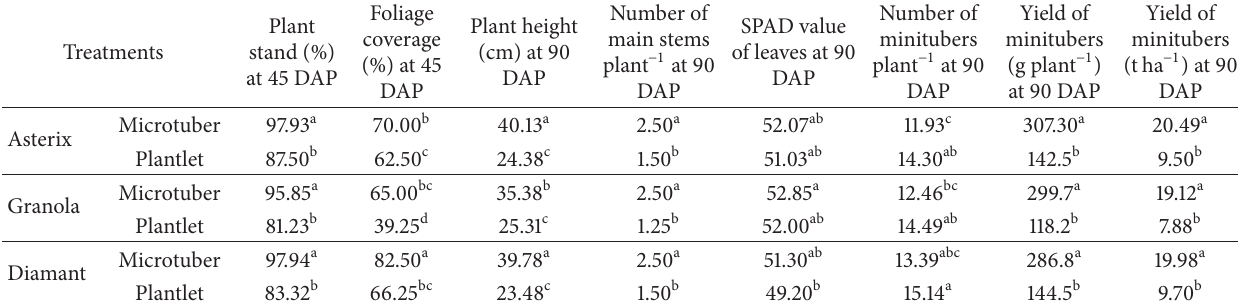
Table 3: Interaction effect of variety and planting materials in field condition.